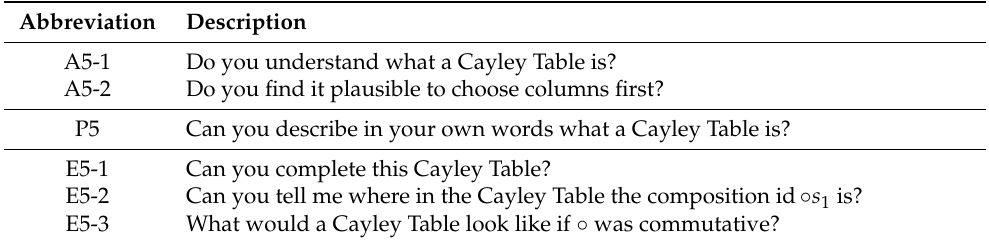
Table A5. Overview and descriptions for all units included in the interview regarding key idea 5 ( Cayley Tables , cf. Table 1). A stands for acceptance, P for paraphrasing, and E for exercise.